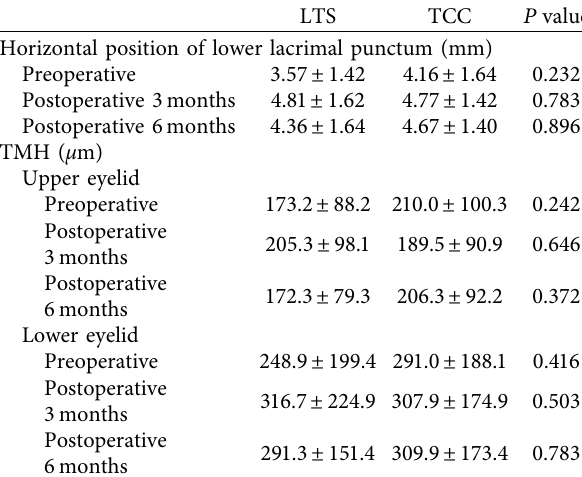
Table 3: Comparison of measurement results between patients who underwent lateral tarsal strip (LTS) procedure and trans- canthal canthopexy (TCC).